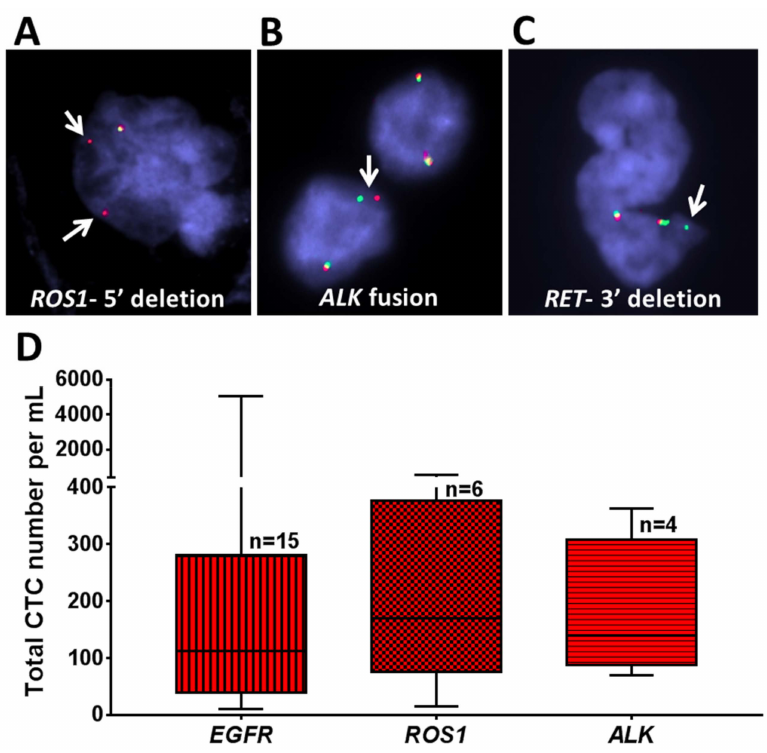
Figure 5. Genomic analysis of NSCLC patient samples using fluorescence in situ hybridization (FISH) analysis. ( A – C ) Recovered CTCs from selected patient samples with di ff erent mutations ( ROS1 , ALK , and RET ) were evaluated. ( A ) A patient with ROS1 rearrangement showed 5 (cid:48) deletion in some of the cells. ( B ) A patient with aberration in ALK showed ALK fusion. ( C ) A patient with aberration in RET showed 3 (cid:48) deletion. Arrows indicate specific aberration in each gene. ( D ) Box plot of the total number of CTCs recovered from patients with di ff erent mutations ( EGFR ( n = 15), ROS1 ( n = 6), and ALK ( n = 4)). Analyses were conducted using GraphPad